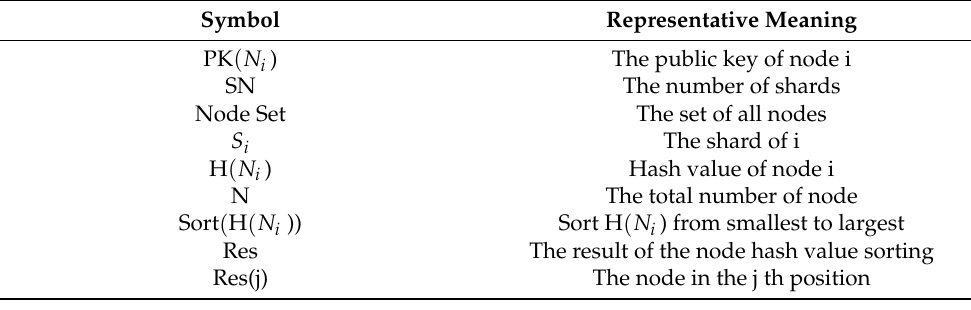
Table 1. Layered sharding formation notations.